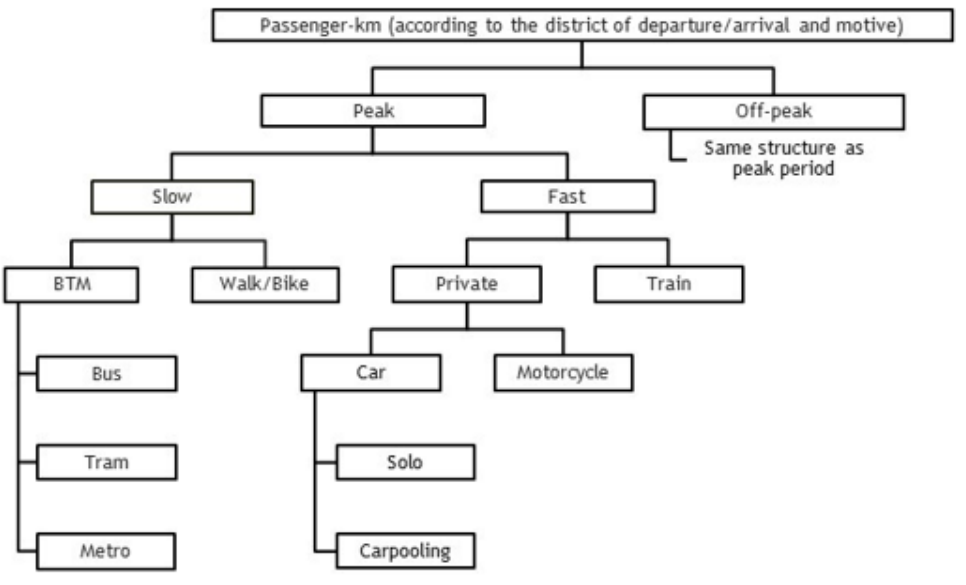
Figure 2. The CES tree for passenger